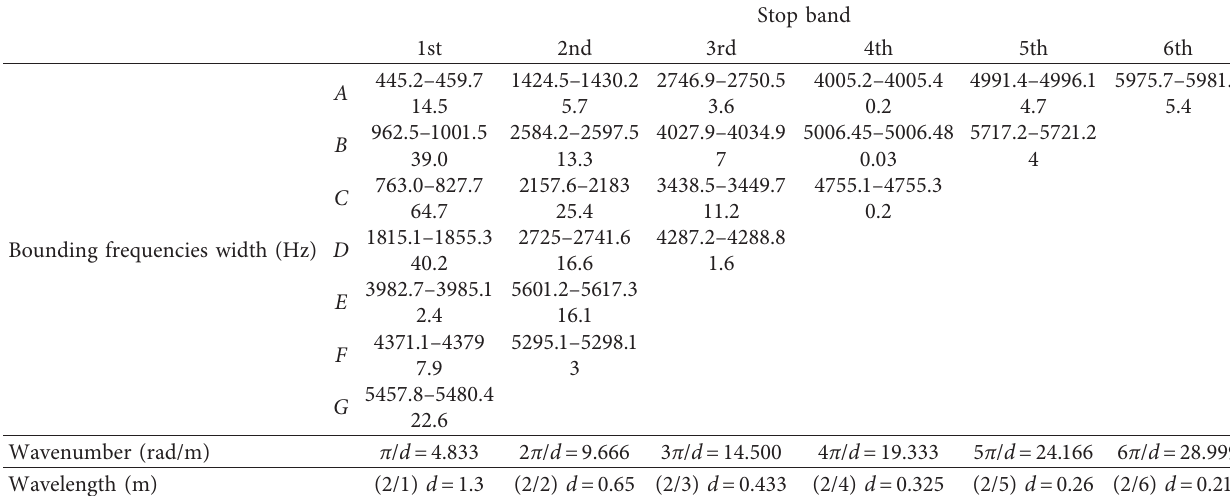
Table 2: The bounding frequencies of stop